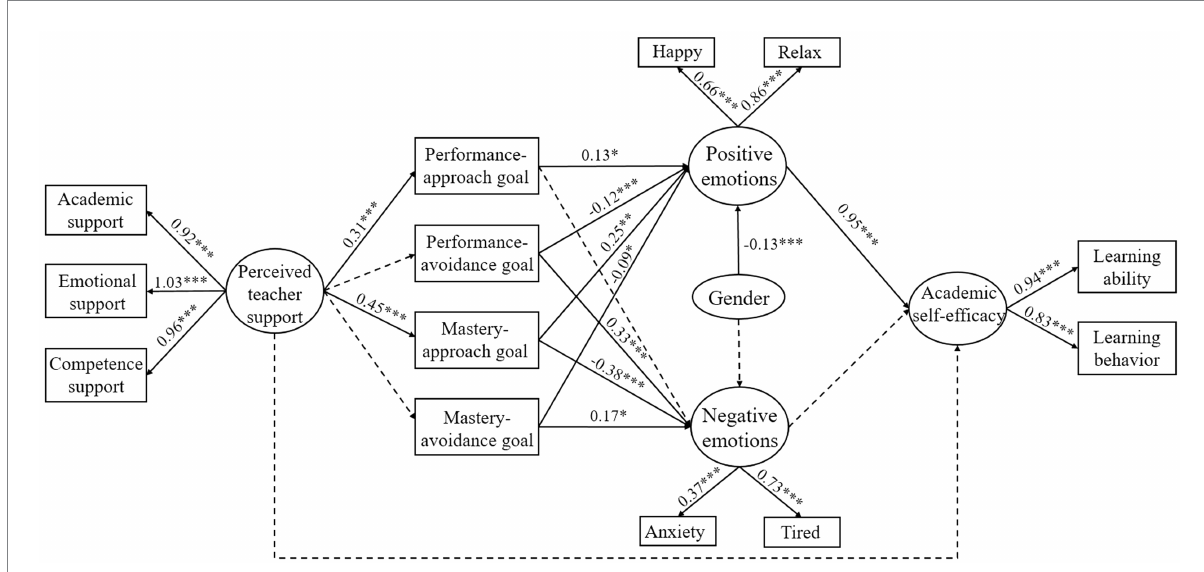
FIGURE 3 Multiple mediation model. The coefficients shown are standardized path coefficients. A solid arrow represents a significant path, and a dotted arrow represents an insignificant path (* p < 0.05, ** p < 0.01, *** p <